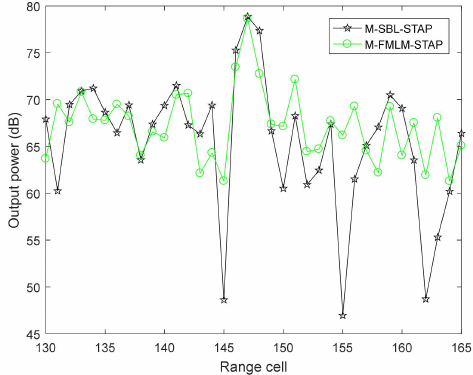
Figure 8. STAP output power to the range cell of two